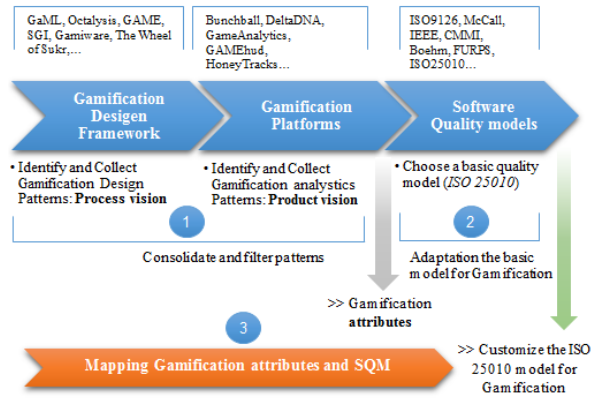
Figure 1 : Synthesis of our working